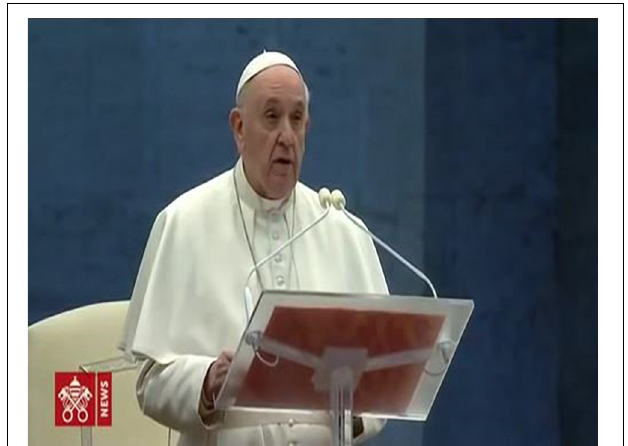
FIGURE 3 | Emphatic facial expression (minute